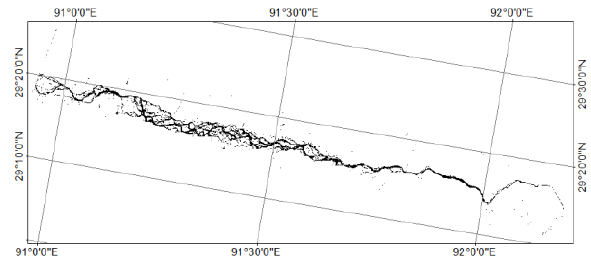
Figure 5. River extraction result using